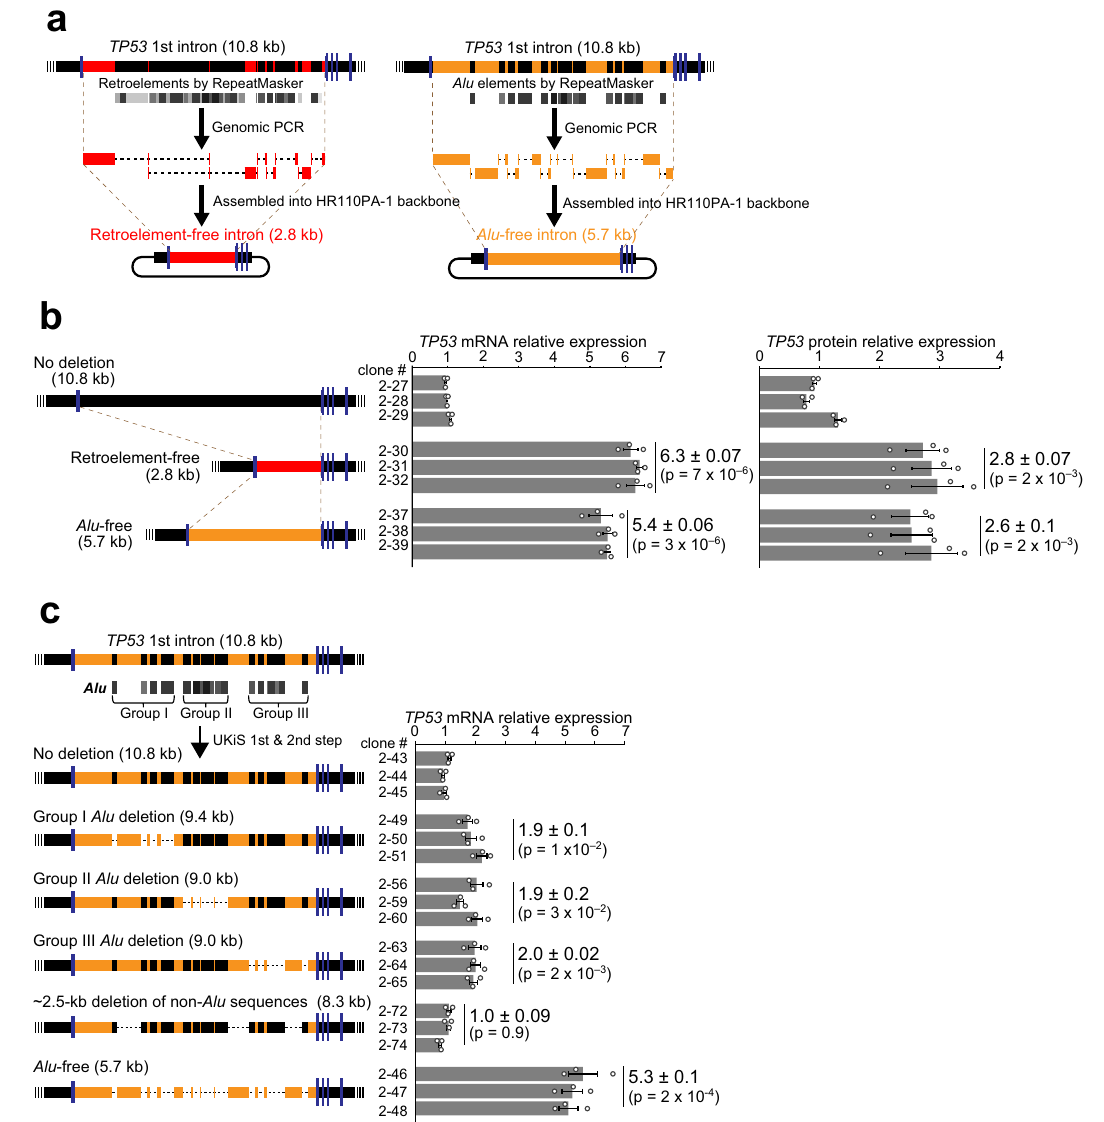
Fig. 6 Removal of retroelement and Alu sequences from the endogenous fi rst intron of TP53 . a Graphic representation of the synthesis of retroelement- and Alu -free versions of the TP53 fi rst intron. Non-retroelement and non- Alu sequences are shown in red and orange, respectively. b Transcriptional and translational impacts of retroelement and Alu removal on TP53 expression. c Transcriptional impacts of partial removal of Alu elements and removal of non- Alu sequences on TP53 transcription. The removed regions are denoted by dashed lines in the schematic drawings of the 5 deletion mutants. In ( b ) and ( c ), three clones of each mutant cell were subjected to real-time RT-PCR ( b , c ) and immunoblotting ( b ). 18S rRNA was used as an internal control for real-time RT-PCR. Relative fold-changes were calculated by the ΔΔ Ct method. For immunoblotting, α -Tubulin was used as an internal control. Data in ( b , c ) represent the mean ± SD of three independent RT-PCR experiments, and the p -values (in parentheses; relative to the human intron clones) were determined by a two-tailed Student ’ s t-test, based on three independent experiments for the individual clones. Source data in ( b , c ) are provided as a Source Data fi